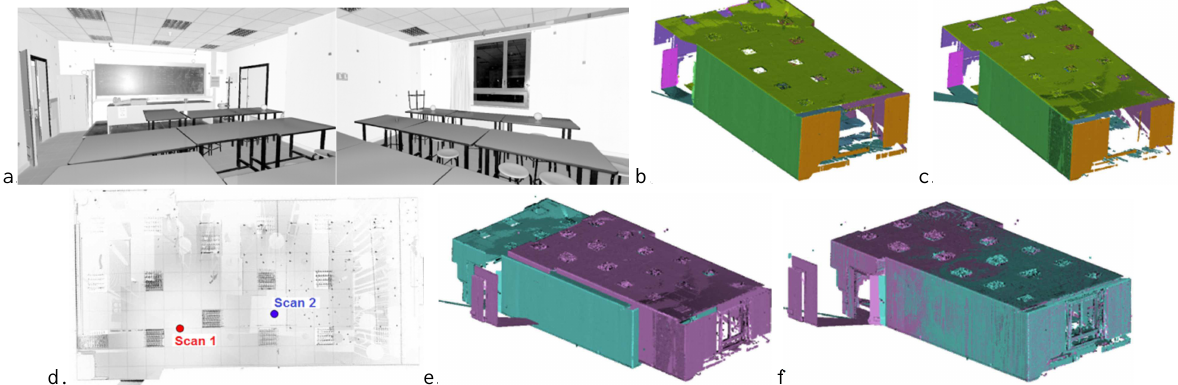
Figure 4. ‘Classroom’ data set registration results. Laser intensity images from bot scan stations (a); segmentation results for Scan 1 (b) and Scan 2 (c), where corresponding segments are represented with the same colour; estimated positions of scan stations (d); scan alignment before (e) and after the registration (f).